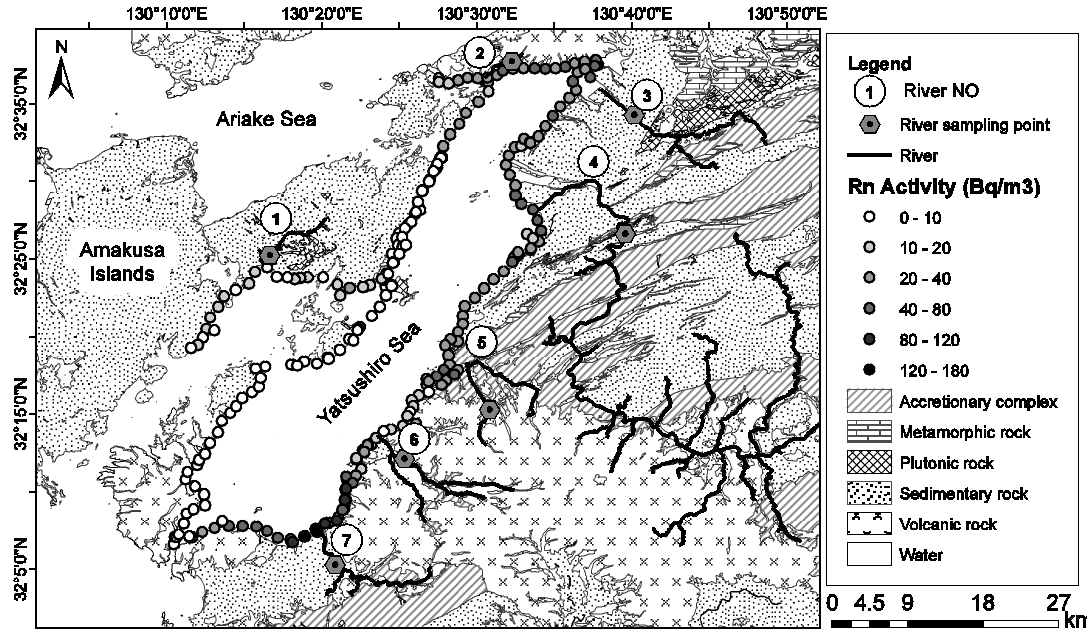
Fig. 4 The distribution map of 222 Rn concentration in sea water in the study